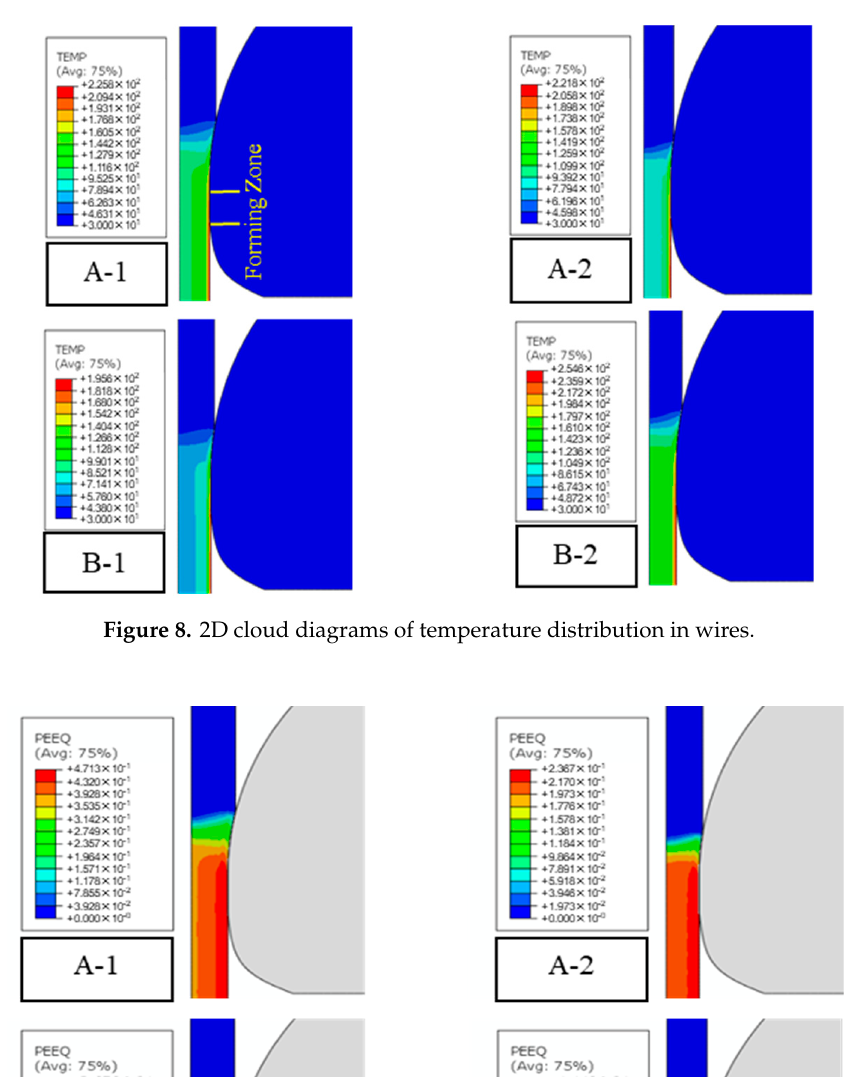
Figure 7. Radial variation of temperature in wires.